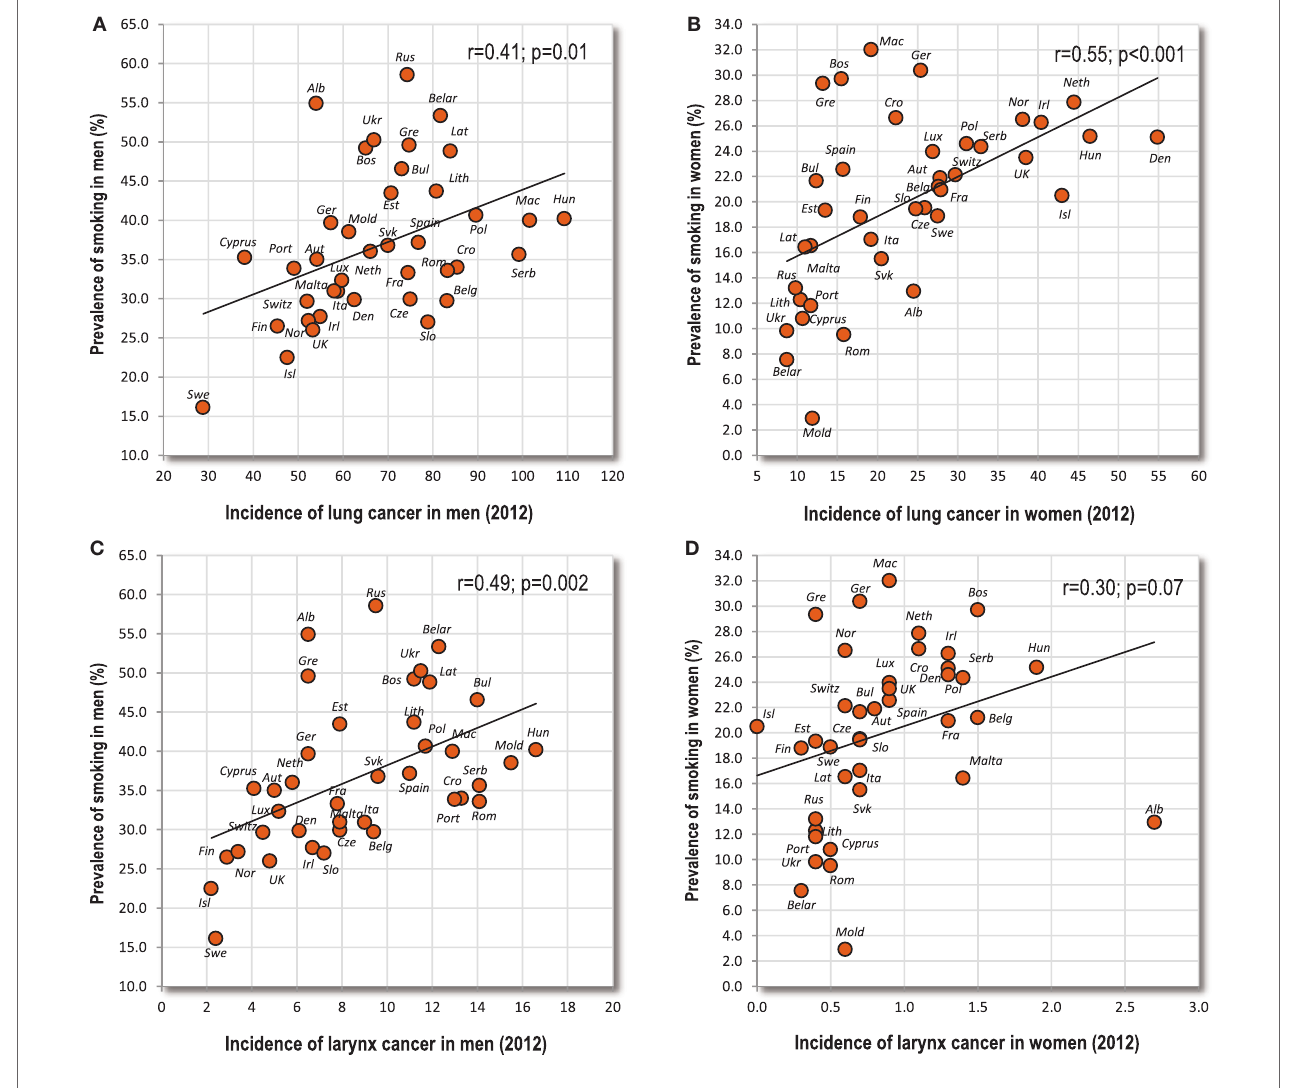
FigUre 3 | (a–D) Relationship between the prevalence of smoking, and lung and larynx